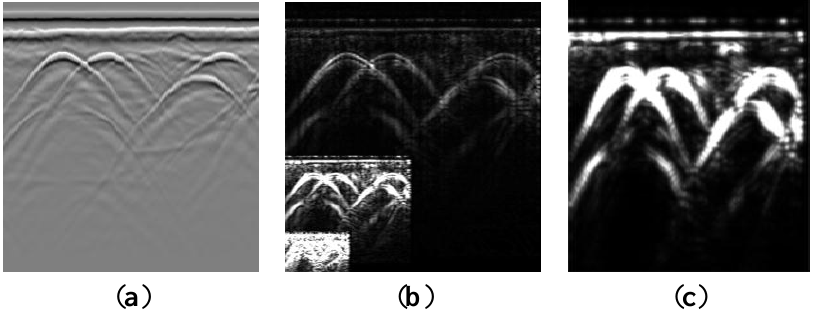
Figure 3. Example of amplitude components extracted by the MMSA method. ( a ) Input image; ( b ) Wavelet-domain amplitude estimation. Three amplitude components under three level monogenic wavelet analysis. The amplitude components eliminate the direct and surface-wave noise; ( c ) The enlarged second amplitude component.